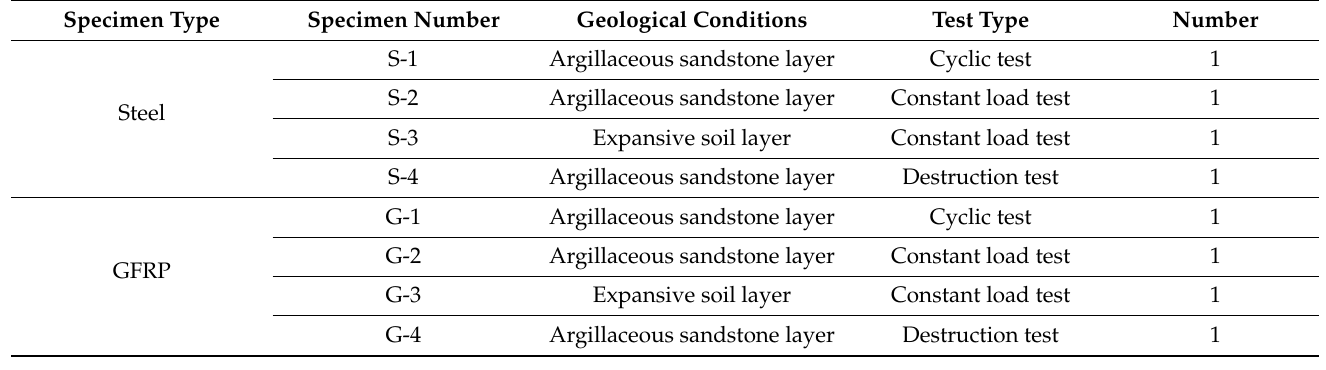
Table 5. Testing bar arrangement.